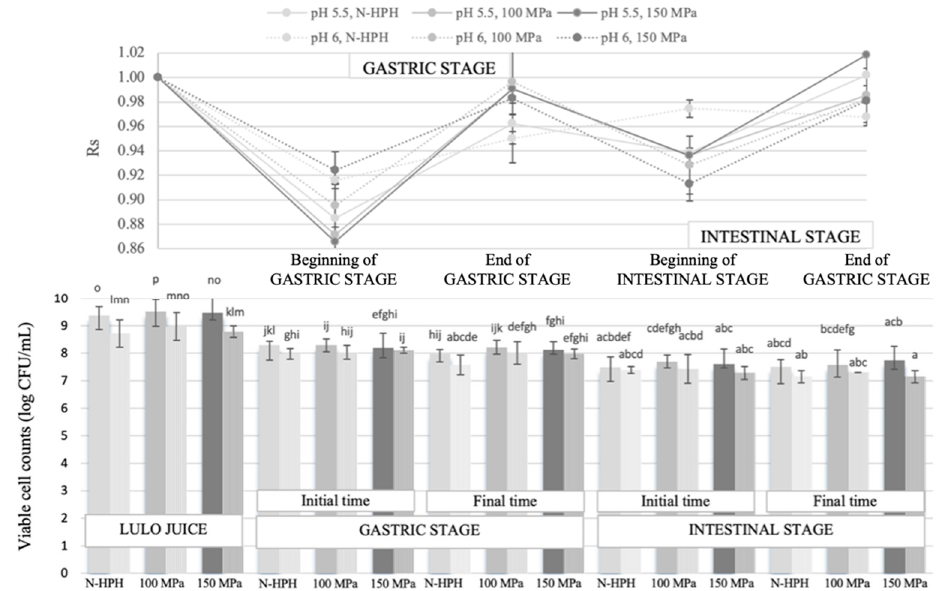
Figure 4. Viable cell counts and survival rate (Rs) of Lactobacillus reuteri along gastric and intestinal stages of the simulated gastrointestinal digestion process in vitro . Fermented lulo juices at pH 5.5 and 6, non-homogenized (N-HPH) and homogenized at 100 MPa (100 MPa) and 150 MPa (150 MPa) has been included. The solid bars refer to juices with pH 5.5 and the striped bars refer to juices with pH 6. Different letters denote significant differences ( p ≤ 0.05).